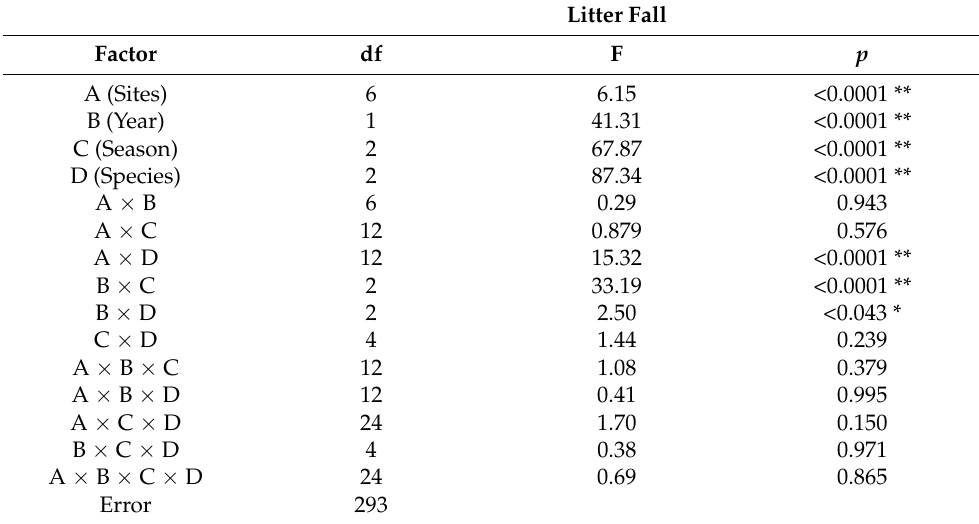
Table 4. Four factorial repeated measurement ANOVAs on the effects of site (Peten Neyac, R í o Verde, Champot ó n, Sabancuy, Xibuja, Estero Pargo and Atasta), year (2009 and 2010), seasons (dry, rainy and Nortes) and species ( Rhizophora mangle , Avicennia germinans and Laguncularia racemosa ) on the litterfall production and components along the Campeche coast, with a significance level of p <